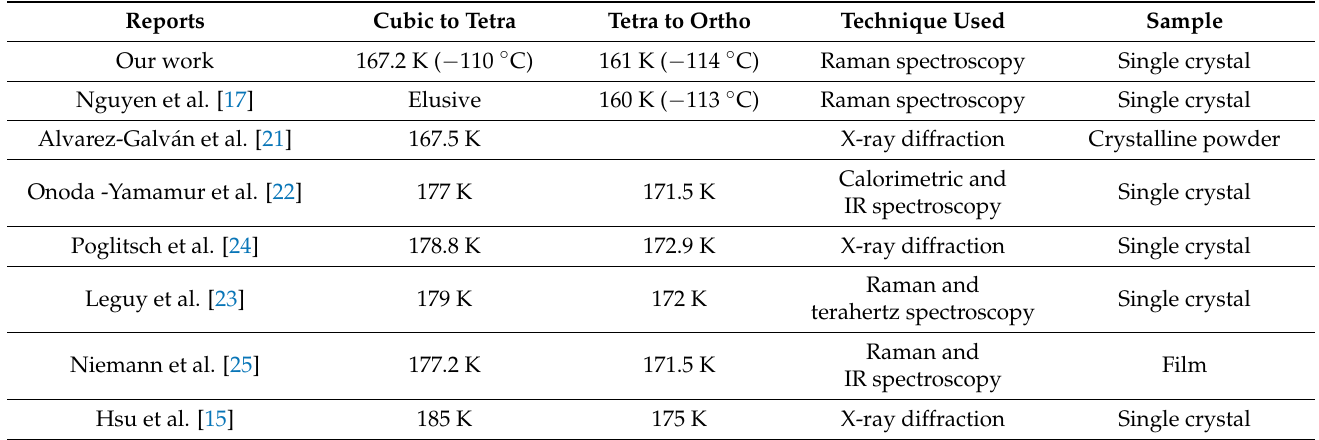
Table 1. Comparison of phase transition temperatures of MAPbCl 3 in previous